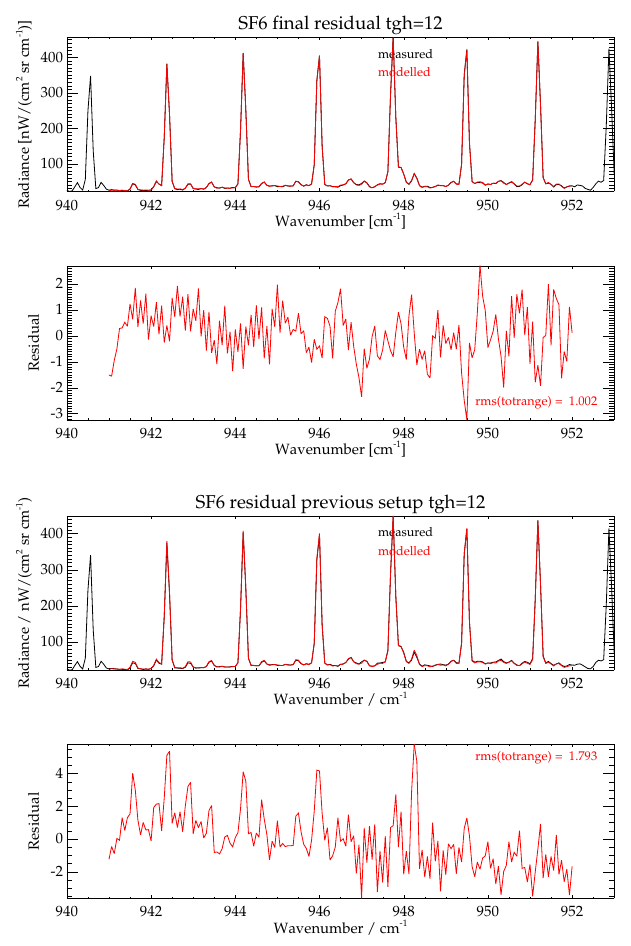
Figure 2. Coadded spectra (measured and modelled) and residu- als for tangent height 12 (approx. 24km) over 1 day for the final retrieval setup (upper panels) and for the previous retrieval setup (lower